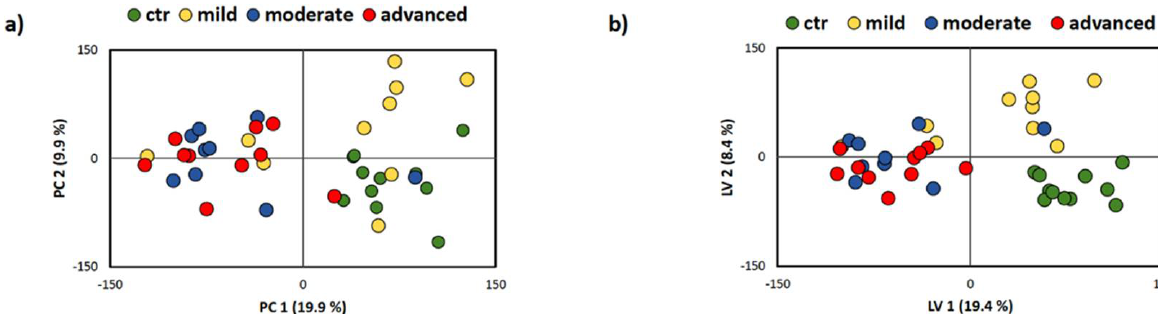
Figure 4. Scores scatter plots obtained via PCA ( a ) and PLS-DA ( b ) of 1D cpmg spectra of plasma from healthy control group and biliary AP patients. Degrees of biliary AP severity are indicated in the legends above the plots.